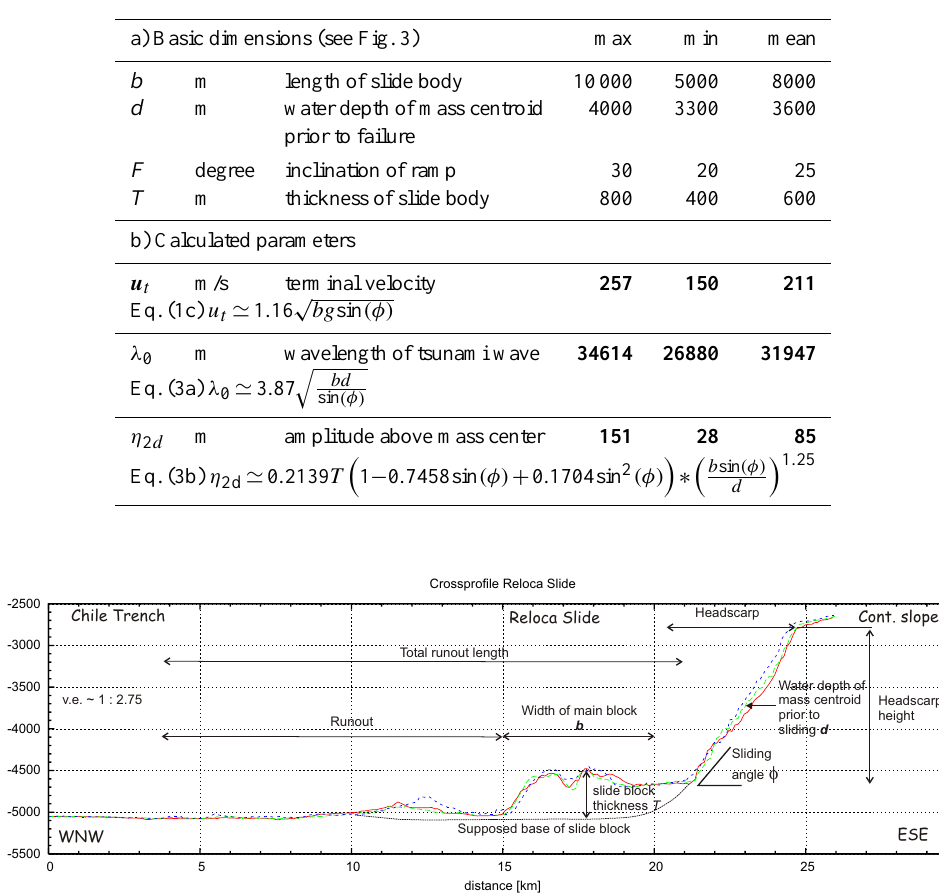
Table 2. a) Basic dimensions of Reloca Slide, b) terminal velocity, tsunami wavelength and tsunami wave amplitude after Watts et al. (2003).